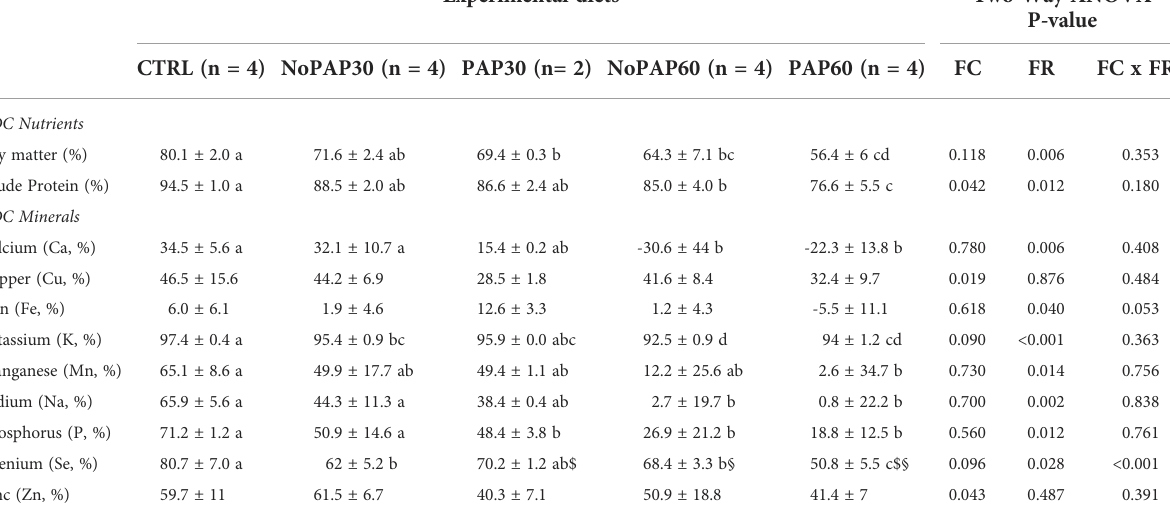
TABLE 6 Apparent digestibility coef fi cients (ADC) of nutrients and minerals of market-sized turbot fed with fed fi ve experimental diets. Experimental